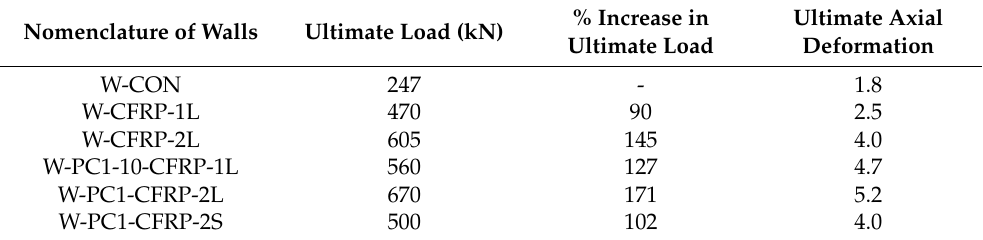
Table 3. Experimental